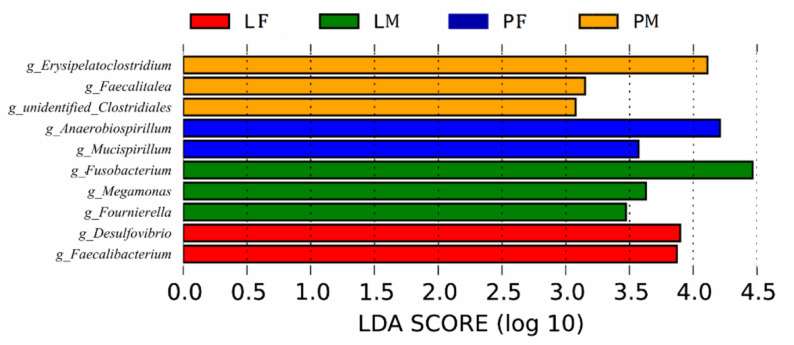
Branching diagram of the linear discriminant analysis (LDA) of cecal bacteria in male and female ducks reared on the floor and in cages. The LDA score for a discriminative feature was >3.0. PF, females reared on the floor; PM, males reared on the floor; LF, females reared in A-type cages.